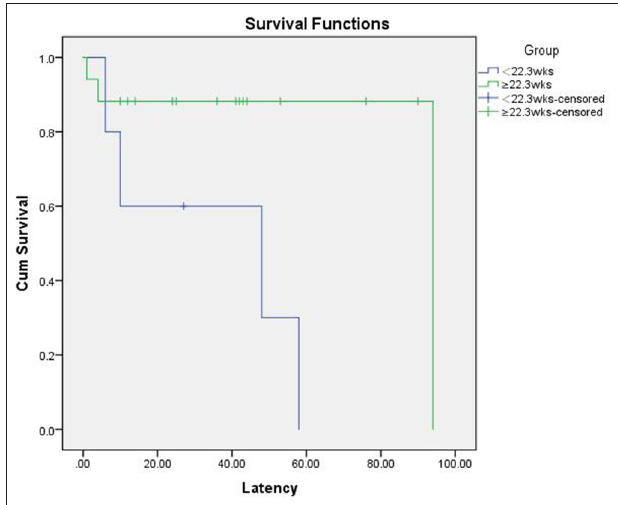
FIGURE 2 | Kaplan–Meier survival curve for neonatal death with gestational age (GA) at repeat cerclage (RC) ≥ 22.3 weeks and < 22.3